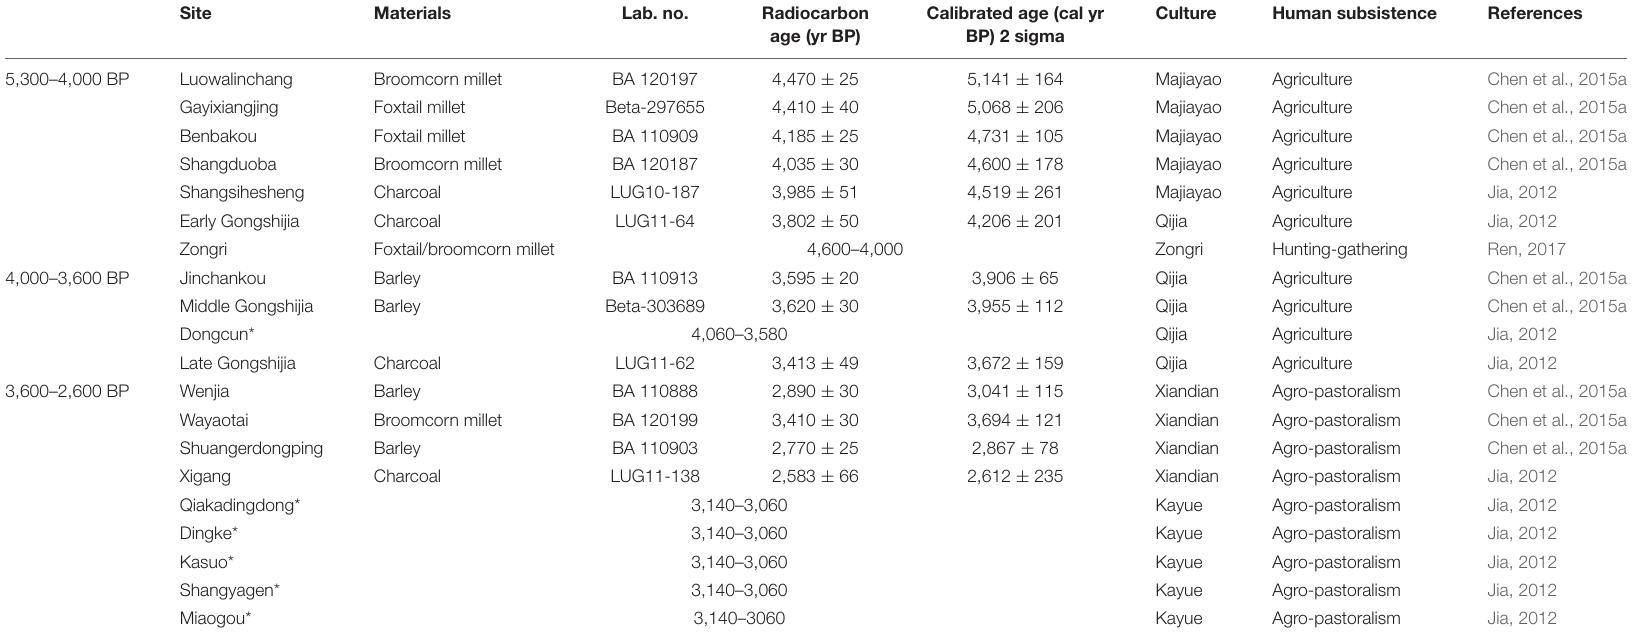
TABLE 1 | Radiocarbon dates of the investigated sites in the NETP during the late Neolithic and Bronze